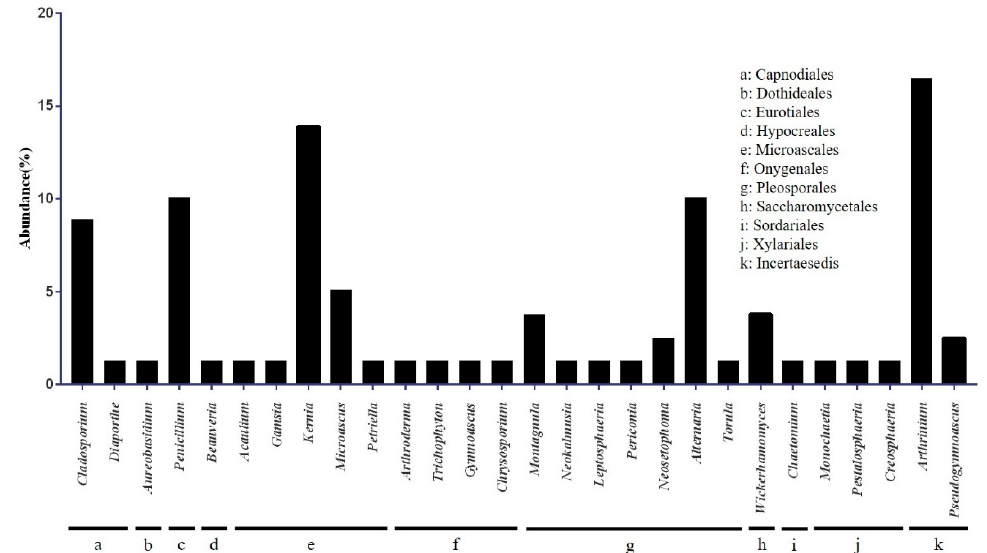
Figure 2. Classification of cultured fungi at the class and genus levels. Seventy-nine fungal colonies were isolated from the two media. Microascaceae was the most dominant family, followed by Apiopo- raceae and Pleosporaceae .